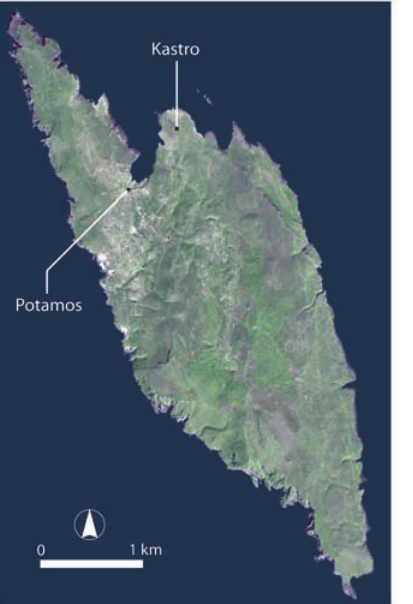
Figure 2 Antikythera with place names mentioned in the text (original image courtesy of Digital